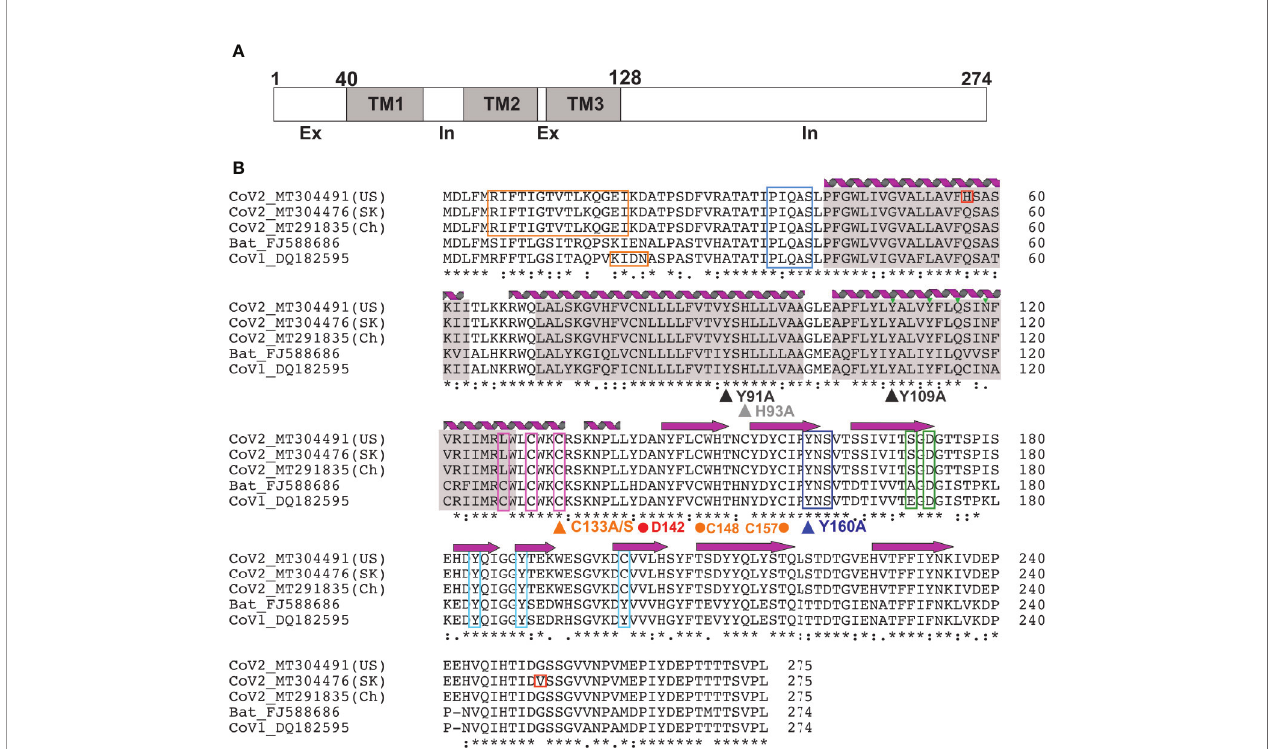
FIGURE 2 | 3a Protein topology and sequence alignment among corona viruses (A) 3a protein topology. (B) Multiple sequence alignment of 3a protein from corona viruses. Secondary structures [alpha helices (coils) and beta strands (arrows)] observed in the EM structure by Kern et al. (41) are indicated. Transmembrane regions (gray), novel mutations in CoV-2 (red), TRAF-binding motif (blue), epitopes for natural antibodies against 3A (orange), cysteines involved in dimer formation (magenta), internalization signal (purple), ER traf fi cking motif (green) and caveolin binding motif (cyan) are shown. Triangles indicate mutations suggested to affect 3a ion channel activity; dots indicate potentially critical residues inferred from the new EM